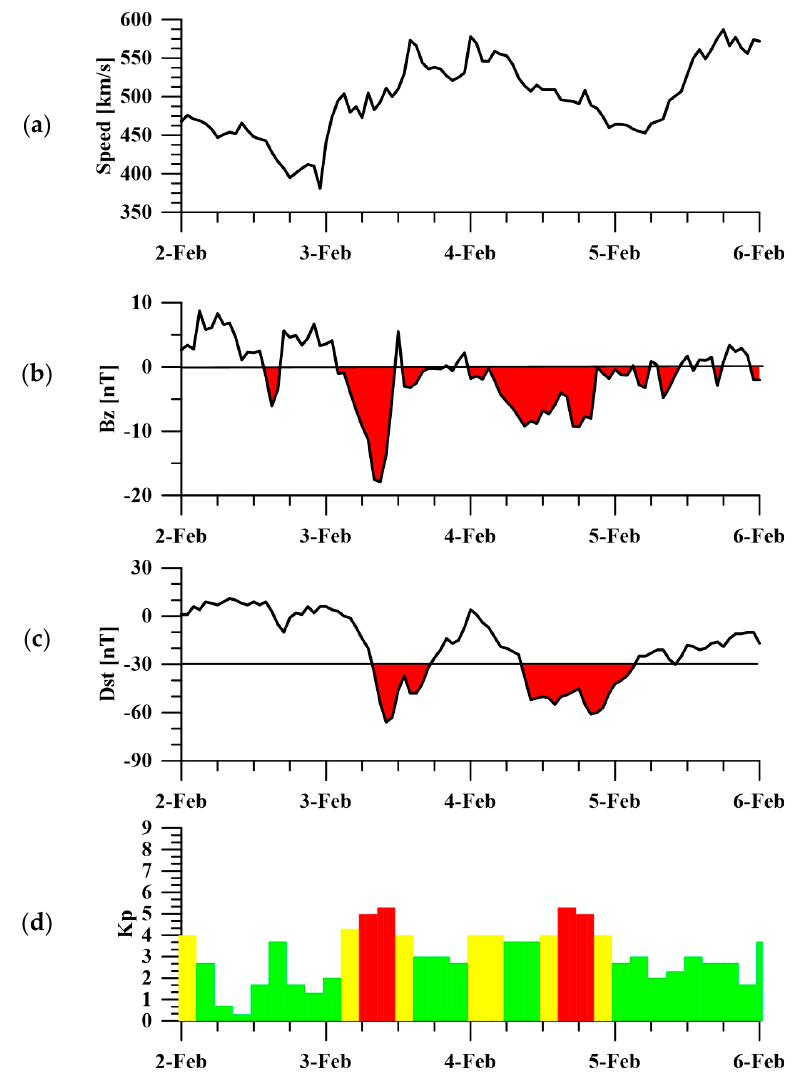
Figure 1. Parameters characterizing the geomagnetic storms on 3 and 4 February 2022: ( a ) speed of solar wind, ( b ) Bz component of IMF, ( c ) Dst index, and ( d ) Kp index. Green color indicates quiet conditions, yellow color indicates active conditions, and red color indicates storm conditions.